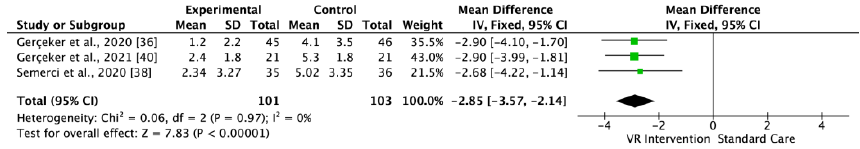
Figure 3. Comparison of VR treatment and standard care, pain (WBS). SD: standard deviation; 95% CI: 95% confidence interval; green square: mean difference; black rhombus: pooled effect.